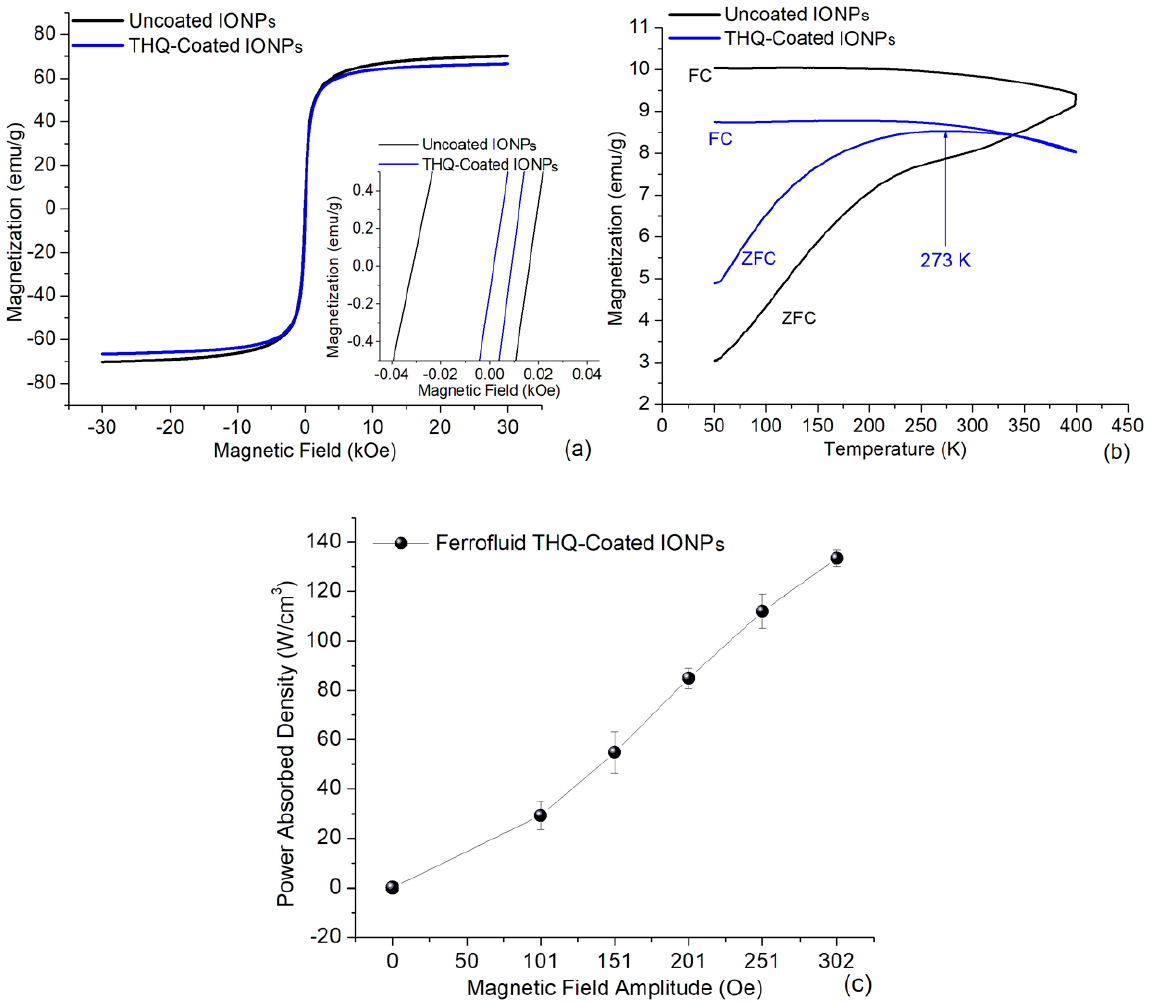
Figure 5. Magnetisation plots of the dried uncoated and coated IONPs ( a ) for magnetic field ( H ) from the range of − 30 to +30 kOe and ( b ) when the temperature ( T ) was increased from 50 to 400 K in a constant magnetic field of 100 Oe. ( c ) The absorbed power density of 1 cm 3 THQ-coated IONPs when H covered the interval from 0 to 301 Oe.